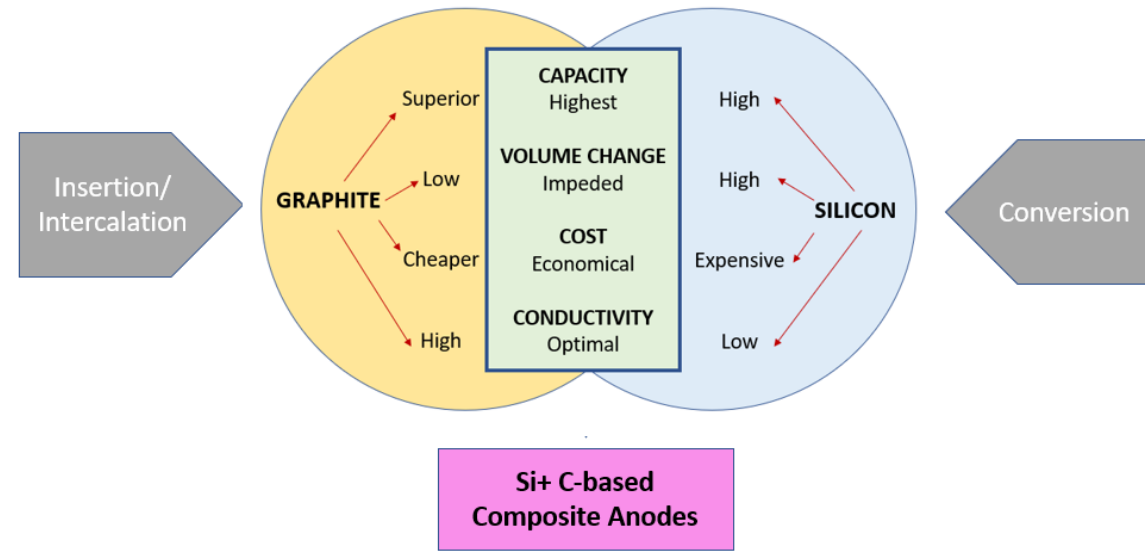
Figure 10. Composite energy storage mechanism.